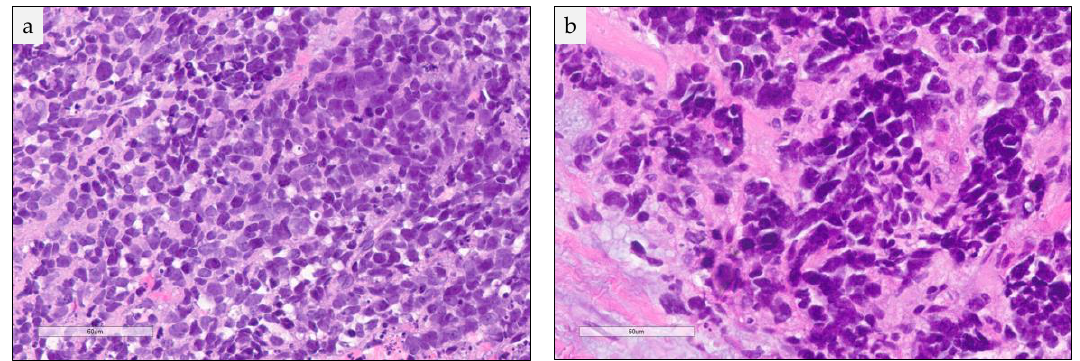
Figure 2. Small cell lung carcinoma (SCLC) cytological and histological characteristics. High power field view of a formalin fixed paraffin embedded tissue H&E stained slide showing in ( a ). sheets of small cells with scant cytoplasm and nuclear molding and ( b ). Sheets of tightly packed small cells and intratumoral necrosis.